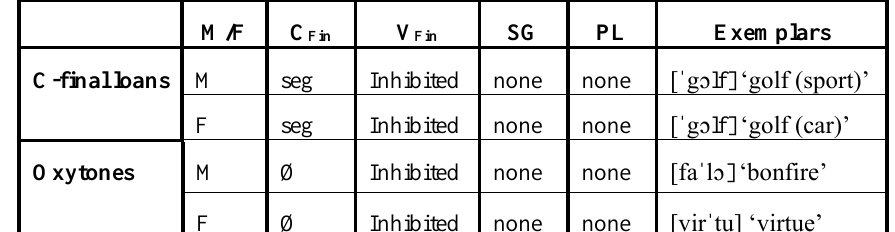
Table 9. Roots with inhibited V